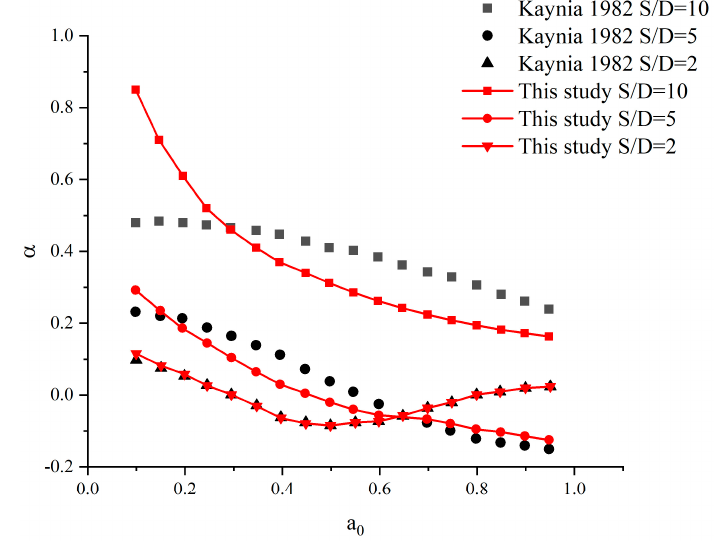
Figure 12. Pile–pile interaction under different pile spacings.